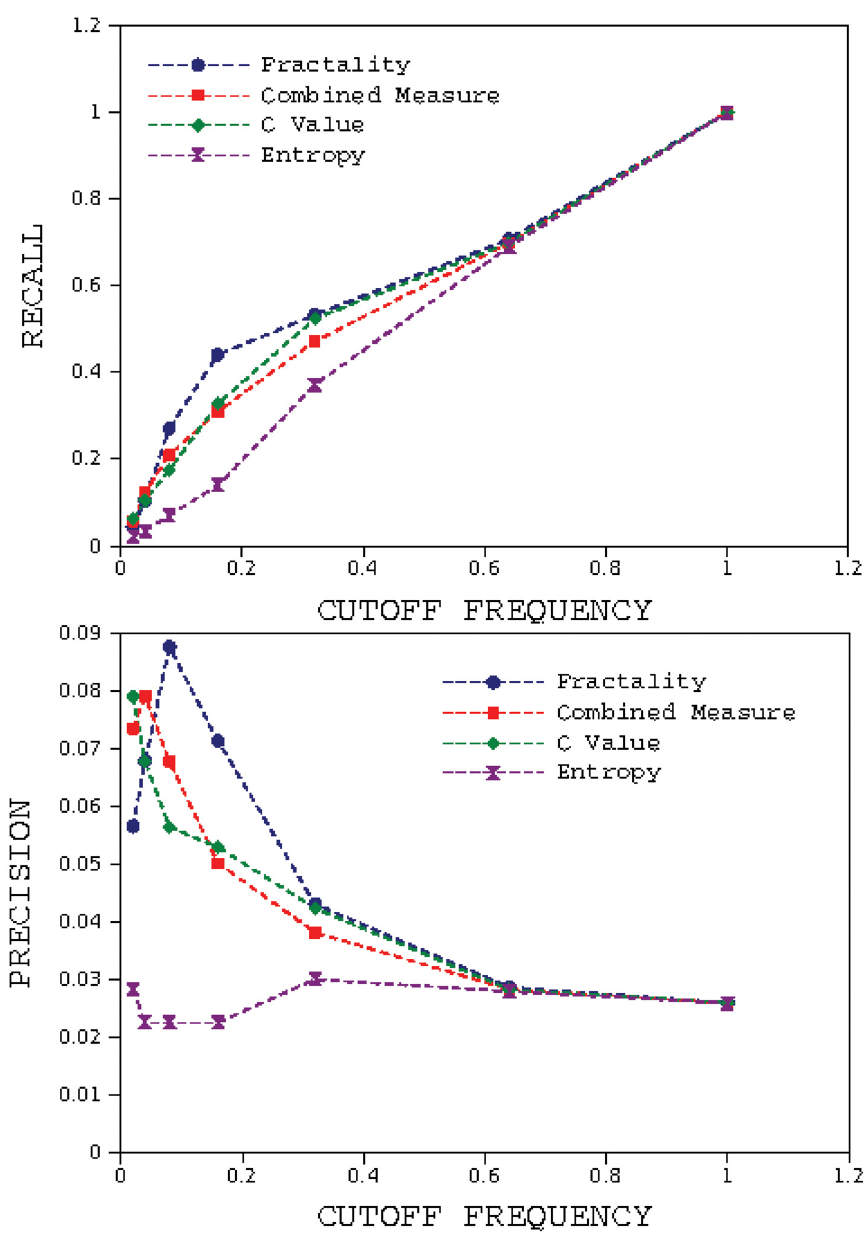
Fig 10. Results of calculating Recall and Precision with Mehri and Darooneh approach for the book The Origin of Species . The fractal method has the highest value of Recall and precision in all vocabulary